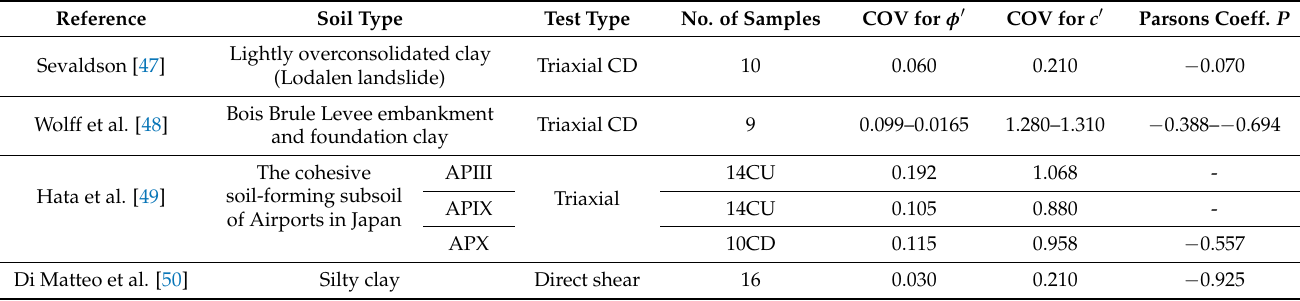
Table 3. Typical values of COV and ρ for effective shearing parameters of cohesive